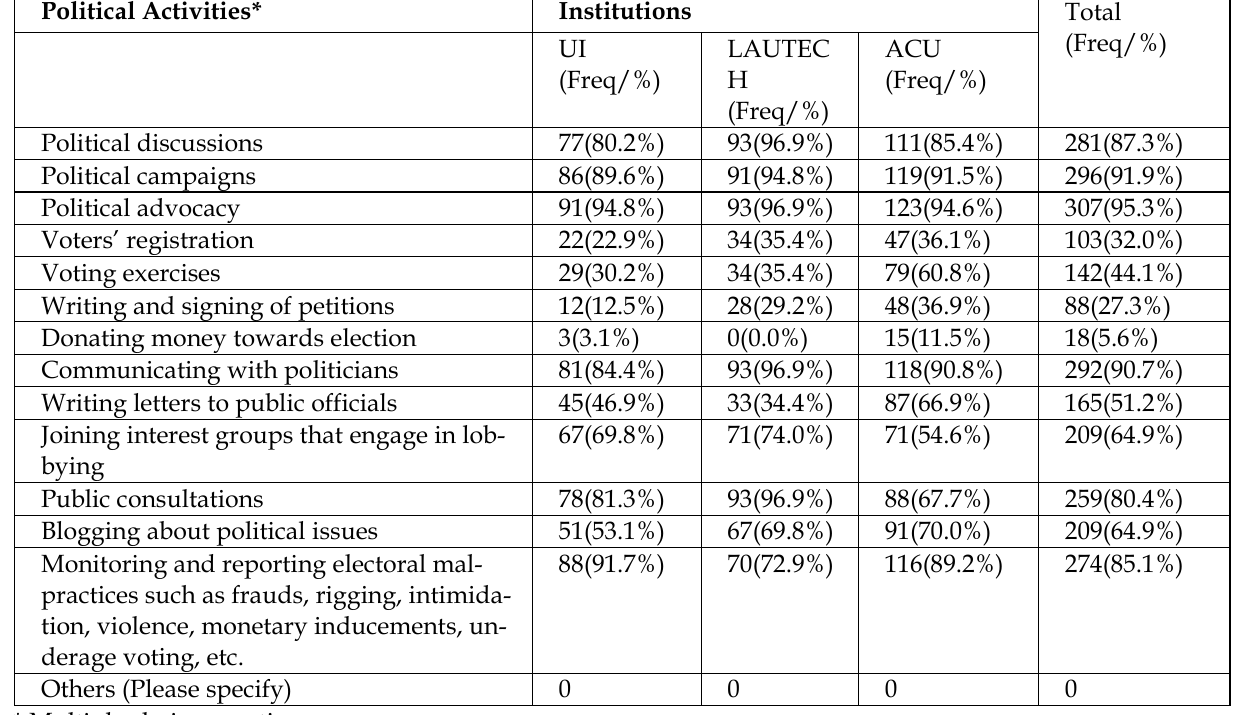
Table 6: Distribution of types of political activities participated with social media Political